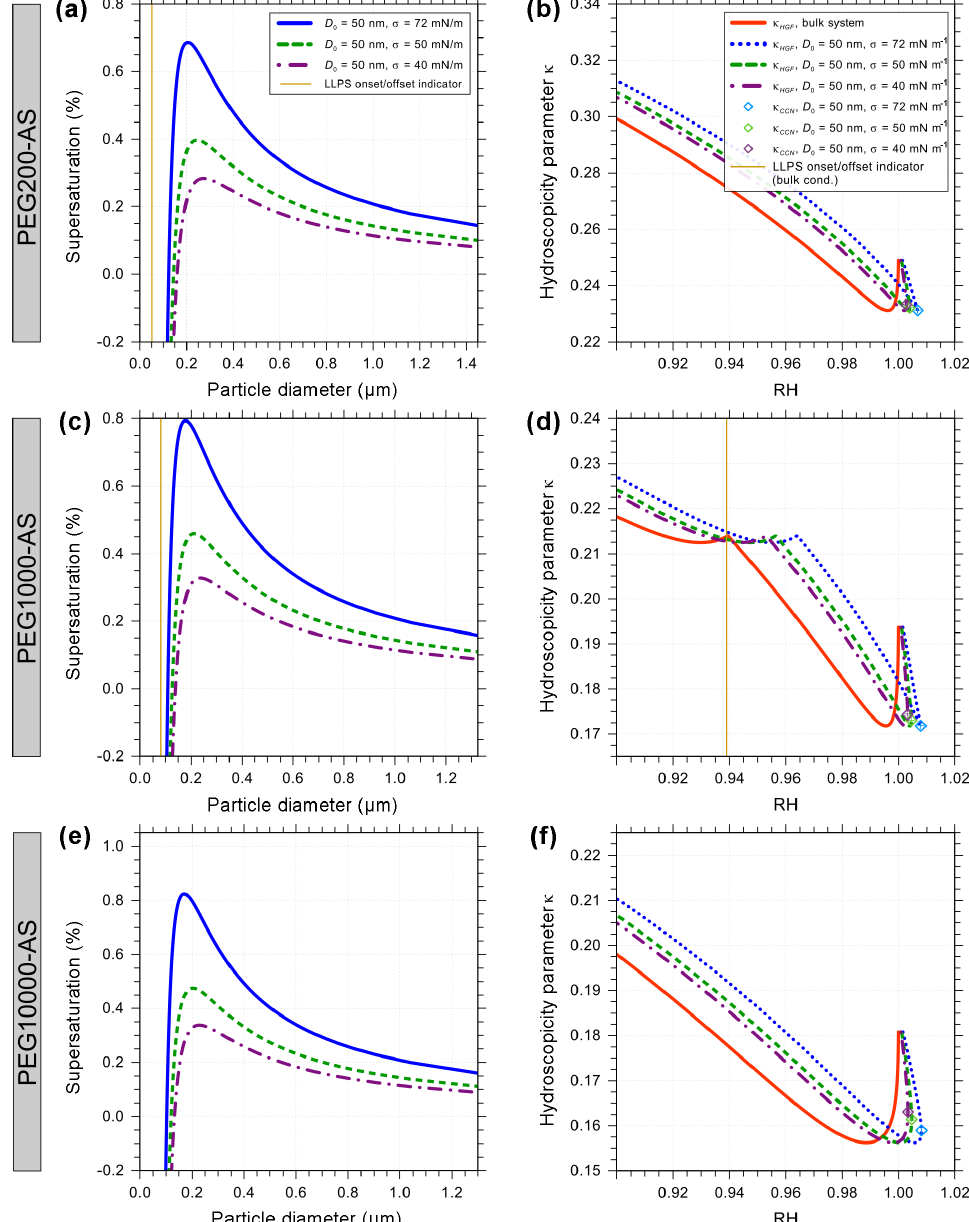
Figure 7. Predicted hygroscopicity properties for the mixed PEG–AS systems with a PEG:AS mass ratio of 2 : 1. Left panels: Köhler curves (equilibrium water supersaturation vs. wet particle diameter). Right panels: predicted hygroscopicity parameter κ in the high-RH range from 90% RH to > 100% RH, i.e., up to supersaturated conditions with respect to liquid water. The curves are based on AIOMFAC-predicted HGF and κ -Köhler theory for particles of dry diameter D 0 = 50nm with different values for the air–particle surface tension σ , as indicated in (a, b) ; all for a temperature of 298.15K. The red curve shows the prediction for the bulk system for the water activity range from 0.9 to 0.99999. The predicted hygroscopicity parameters at CCN activation, κ CCN , are shown by the open diamonds for the given particle properties ( D 0 , σ) , with error bars denoting the numerical resolution of the corresponding maxima in equilibrium supersaturation (related to the maxima of the Köhler curves). The yellow vertical lines indicate the onset of phase separation, with a LLPS existing at RH or particle diameter below the indicated value and a single, homogeneous liquid phase above it. The predictions for the PEG10000-AS system are here based on a ZSR approach (see Sect. 2.4), which treats the particle as an LLPS system for the whole RH range. Note the differences in axis